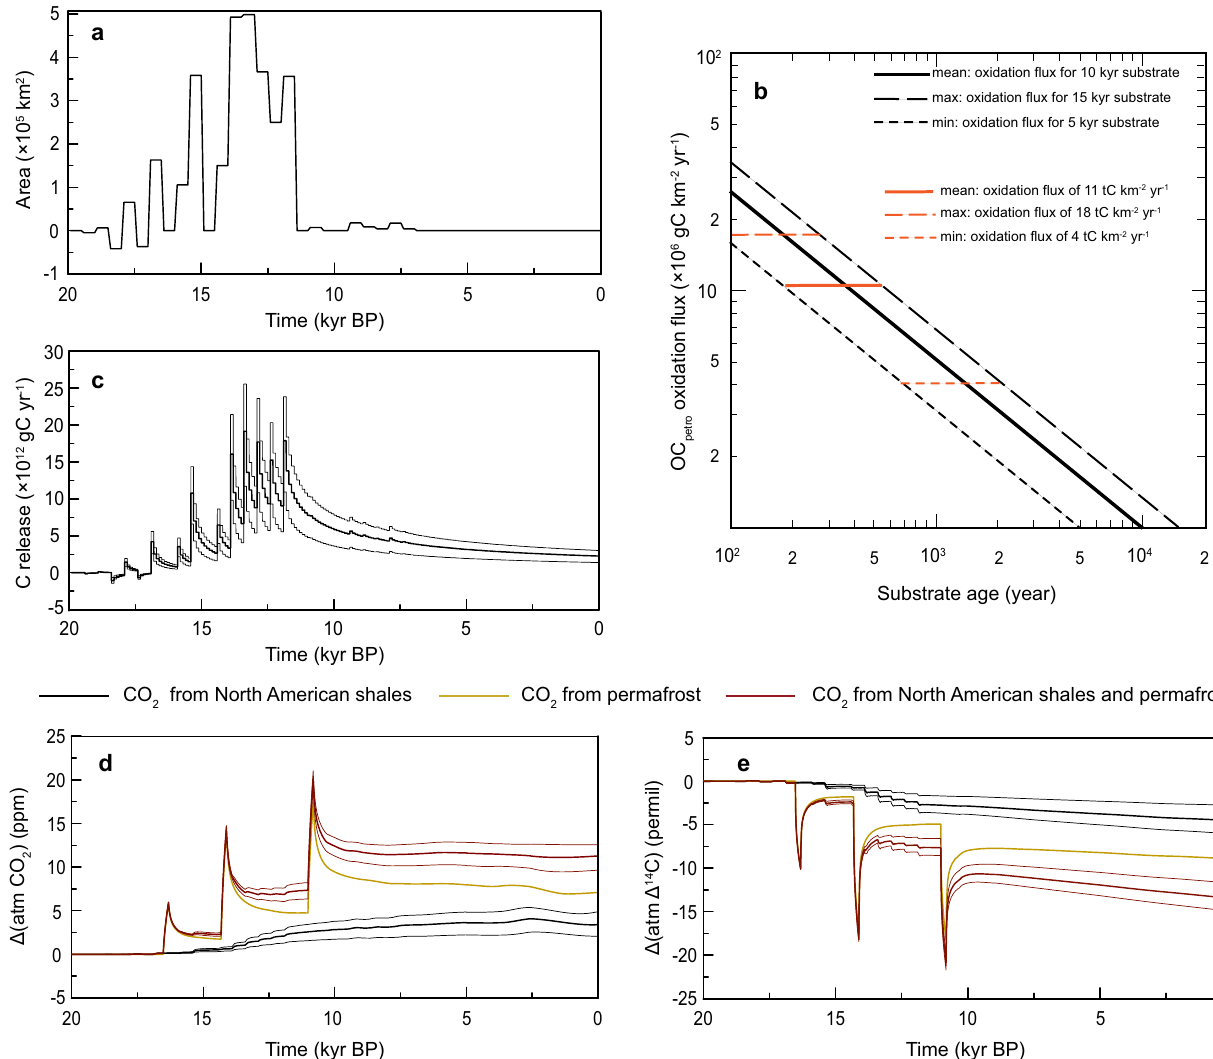
Fig. 5 | Carbon release from OC petro oxidation and simulated impacts on atmospheric CO 2 . a areas of the ice-sheet retreat on shales calculated in steps of 500 years, based on the shales distribution and ice-sheet extent in North America 44,49 ; b assumed long-term OC petro (petrogenic organic carbon) oxidation fl uxes ( F oxidation ) with substrate age ( t ) in North America, following the equation F oxidation = F 0 × t − 0.71 . The black solid line demonstrates a scenario that the modern F oxidation =1tCkm − 2 yr − 1 isvalidforshalesofasubstrateageof10kyrs,andtheblack